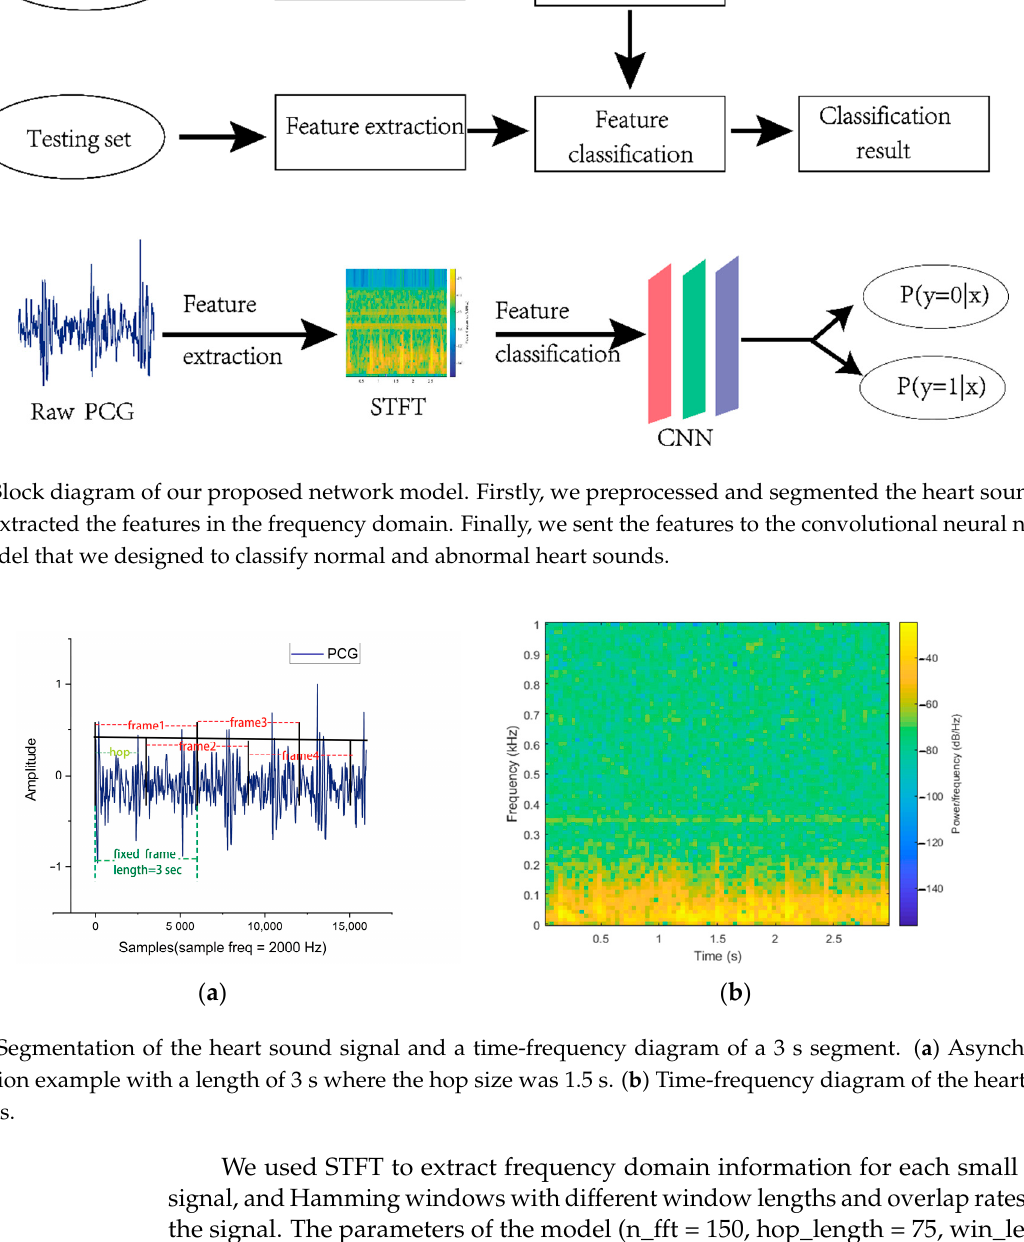
Figure 2. Block diagram of our proposed network model. Firstly, we preprocessed and segmented the heart sound data. Then, we extracted the features in the frequency domain. Finally, we sent the features to the convolutional neural network (CNN) model that we designed to classify normal and abnormal heart sounds.